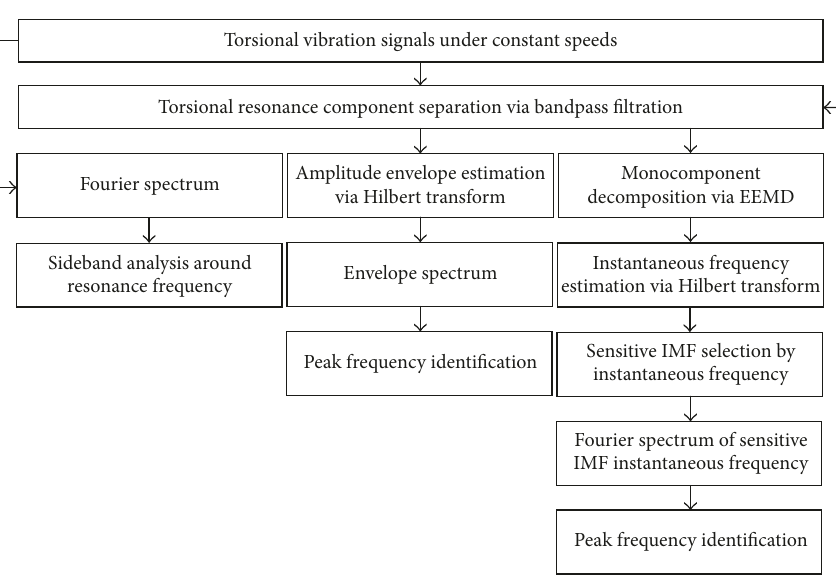
Figure 1: Analysis